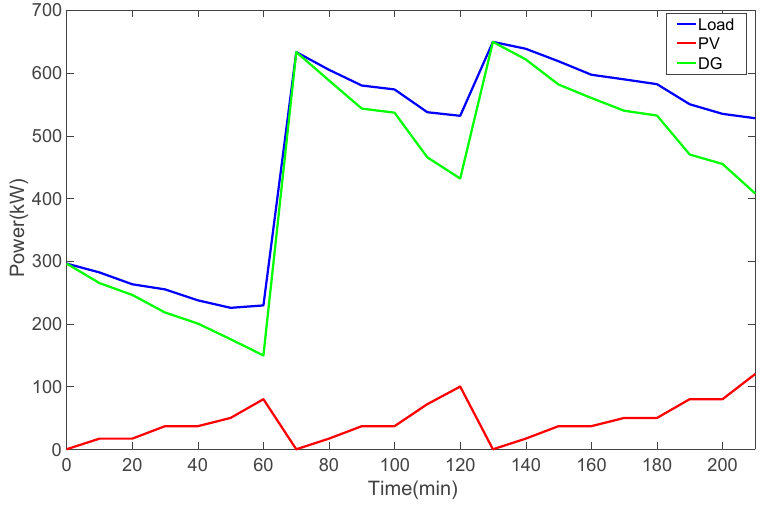
Figure 11. Electrical load, diesel generator power, and solar output power of the ship.